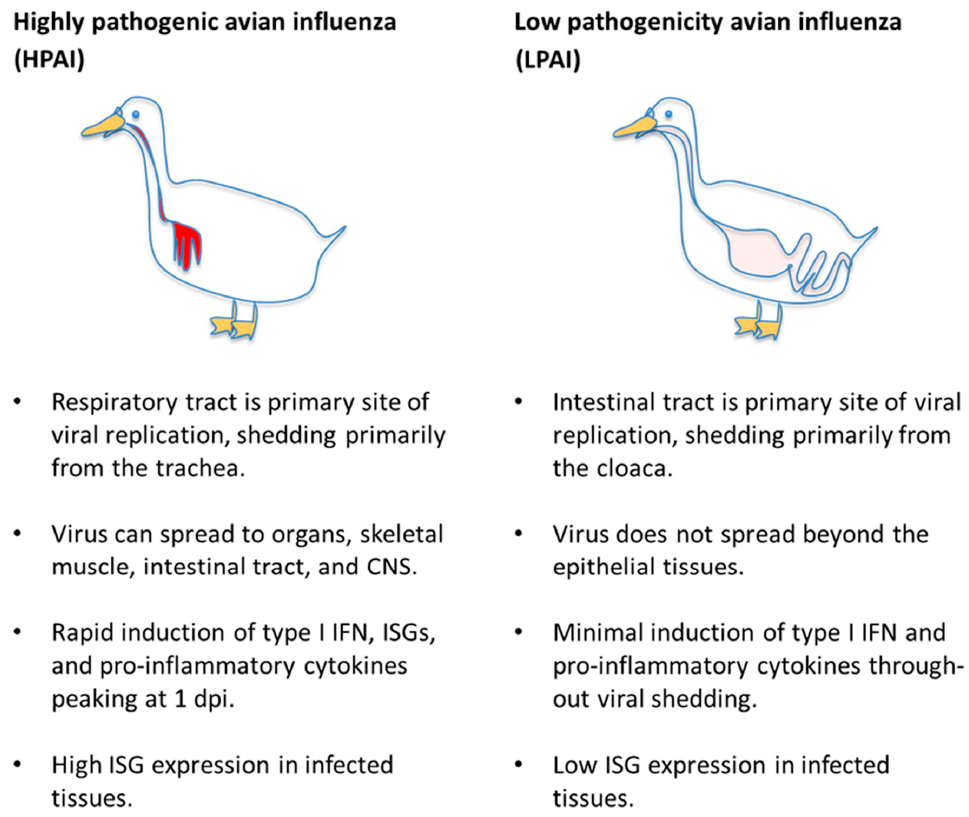
Figure 1. Summary of the generalized innate immune responses of ducks to highly pathogenic and low pathogenicity avian influenza viruses. ISG: interferon-stimulated